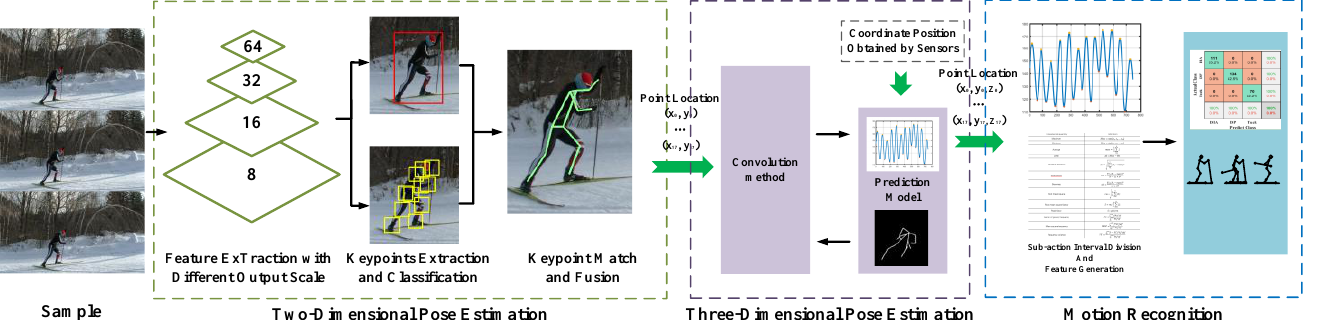
Figure 2. Architecture of monitoring recognition for skiing state.